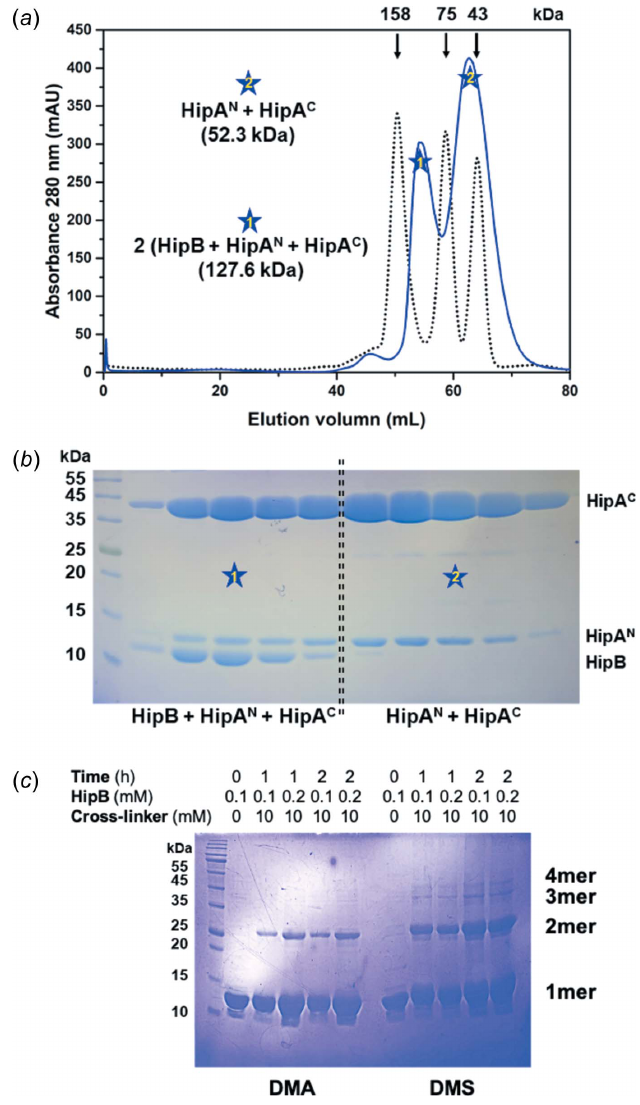
Figure 3 Complex formation of HipB, HipA N and HipA C . ( a ) Purification of tertiary mixtures using size exclusion chromatography. Elution locations of standard proteins with known mass are shown with vertical arrows. The two major peaks of the protein mixture are emphasized with star symbols. ( b ) SDS–PAGE analysis of size exclusion chromatography fractions. Star symbols indicate the lanes to which the starred peaks belong. ( c ) SDS– PAGE analysis of chemical crosslinking of H. influenzae HipB using DMA and DMS crosslinkers. Experimental conditions are indicated above and the corresponding multimer form is labelled on the right side of the